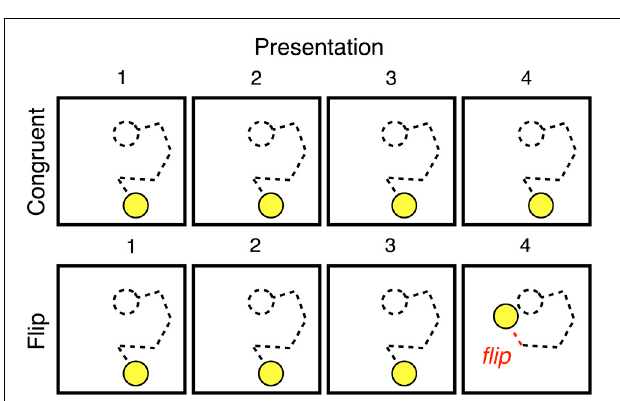
disappeared from view. After a retention interval, a second disk appeared, signaling the subject to begin reproducing from memory the path that had been previously traveled by the yellow disk. Each trial consisted of four such presentations.